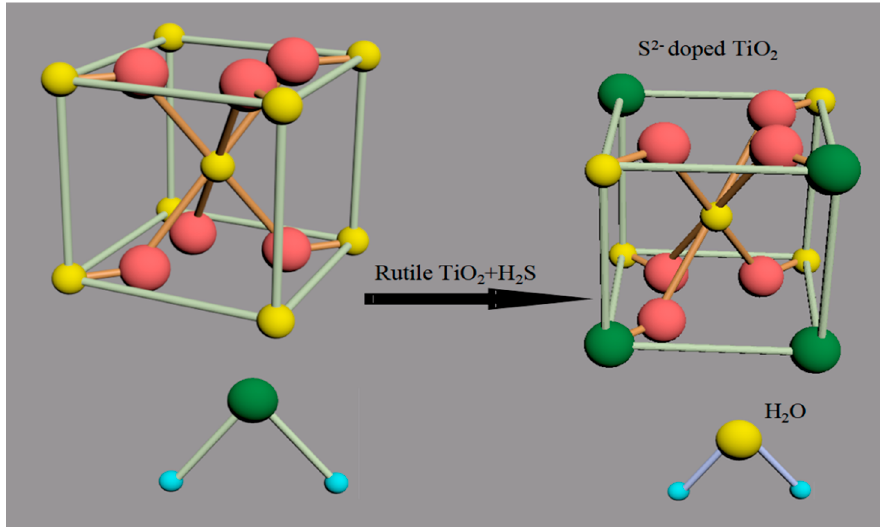
Figure 1. Schematic diagram of the S 2 − -doped rutile TiO 2 crystal growth process.